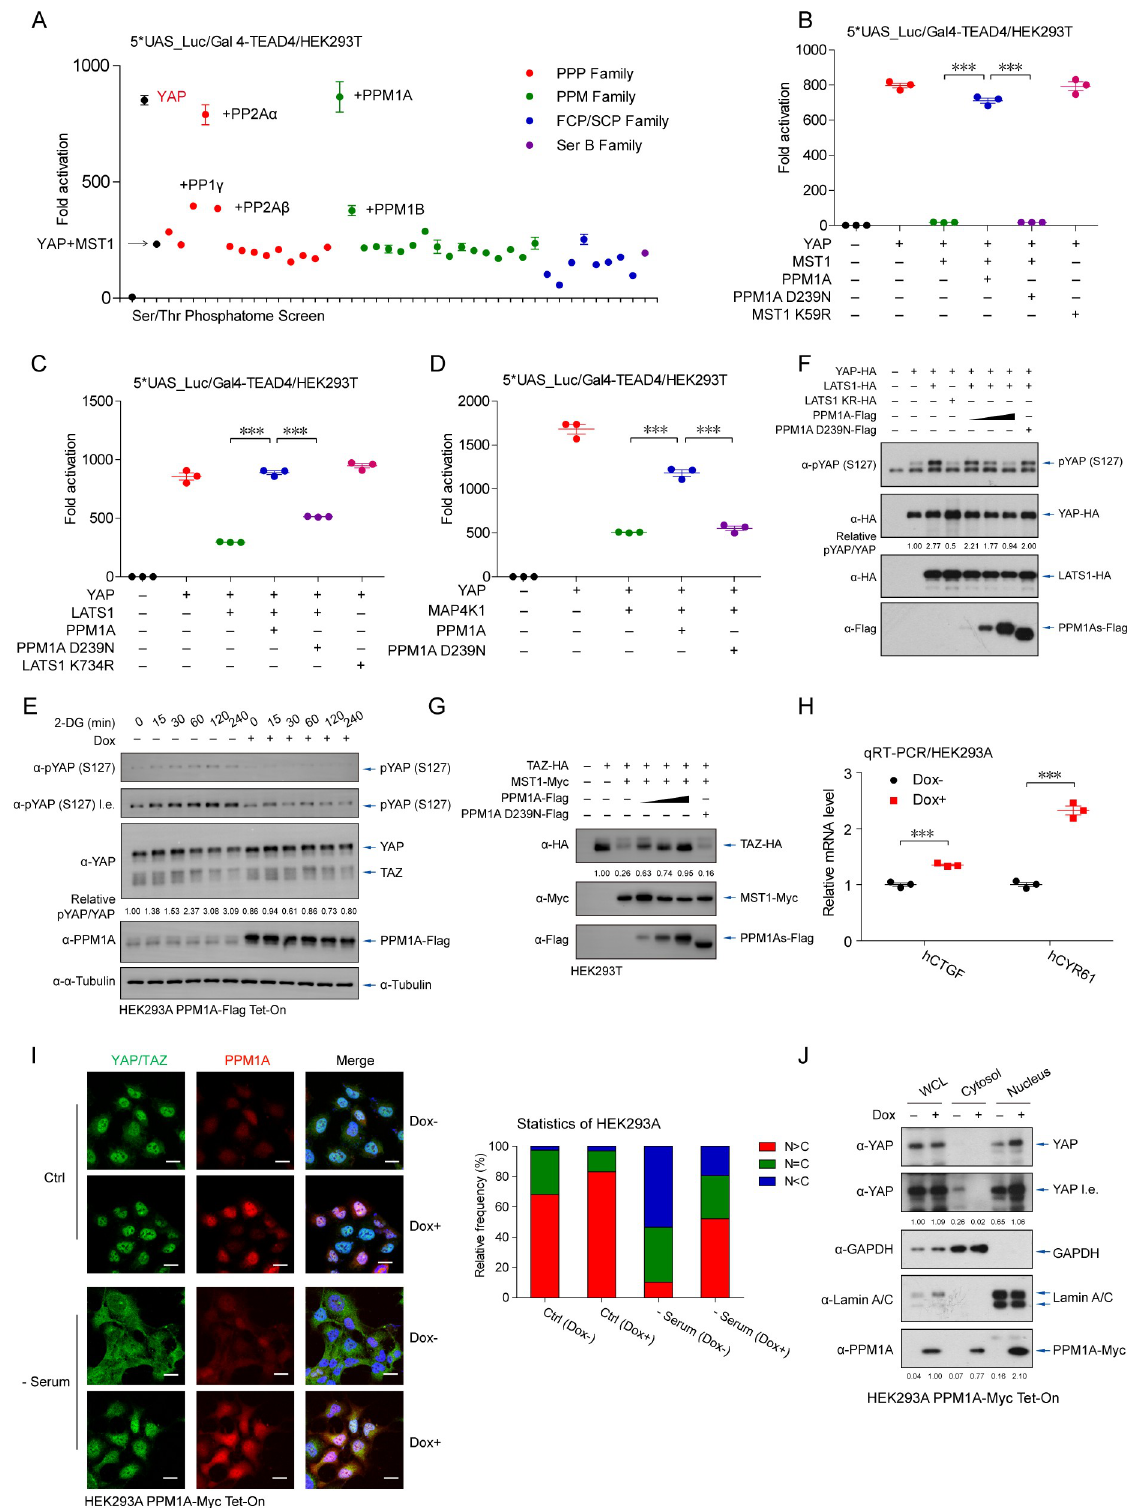
Fig 1. PPM1A facilitates both nuclear distribution and transcription potency of YAP/TAZ. (A) Transcription potency of YAP (5 ng), which drove the TEAD-responsive promoter, was substantially attenuated by coexpression of MST1 (10 ng). Using this setting, a cDNA library comprised of 40 members of serine/threonine phosphatase was screened for their individual contribution in regulating the Hippo-